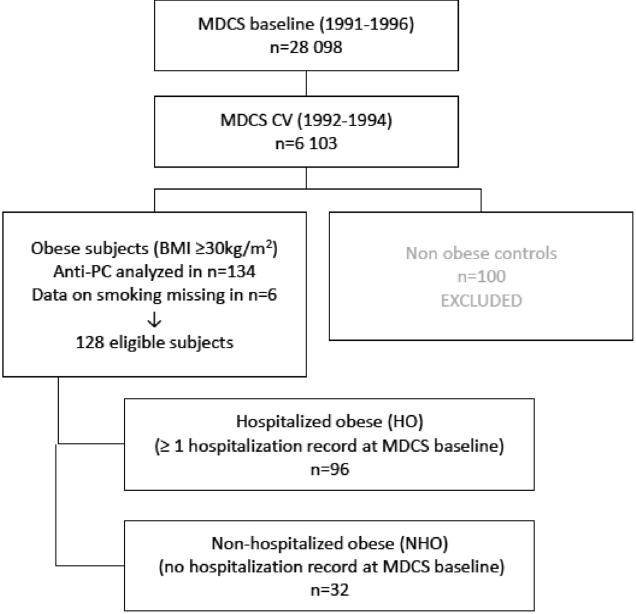
Figure 1. Flow chart of the MDCS-CV sub-cohort stratified for obese and non-obese subjects,